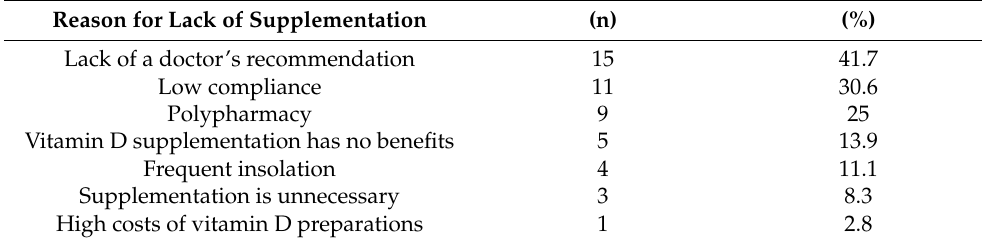
Table 6. MS patients’ reasons for lack of vitamin D supplementation.